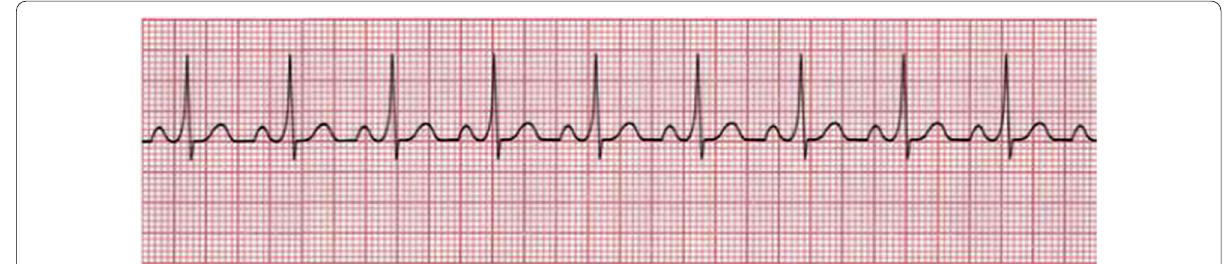
Fig. 4 Morphology of WPW arrhythmia: Figure shows various morphologies of WPW arrhythmia with different